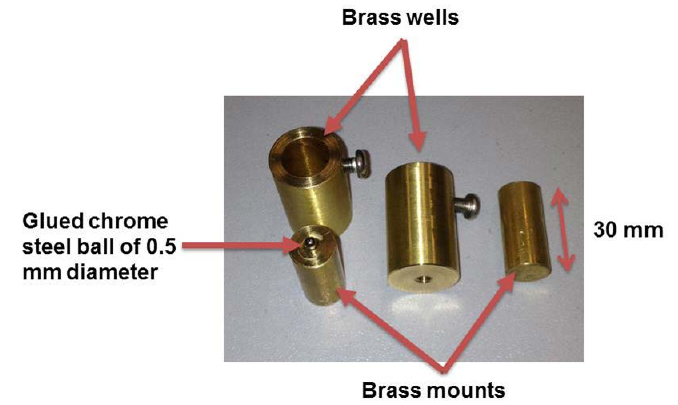
Figure 8. Image of brass mounts and wells used to mount the grains for the micromechanical sliding tests.